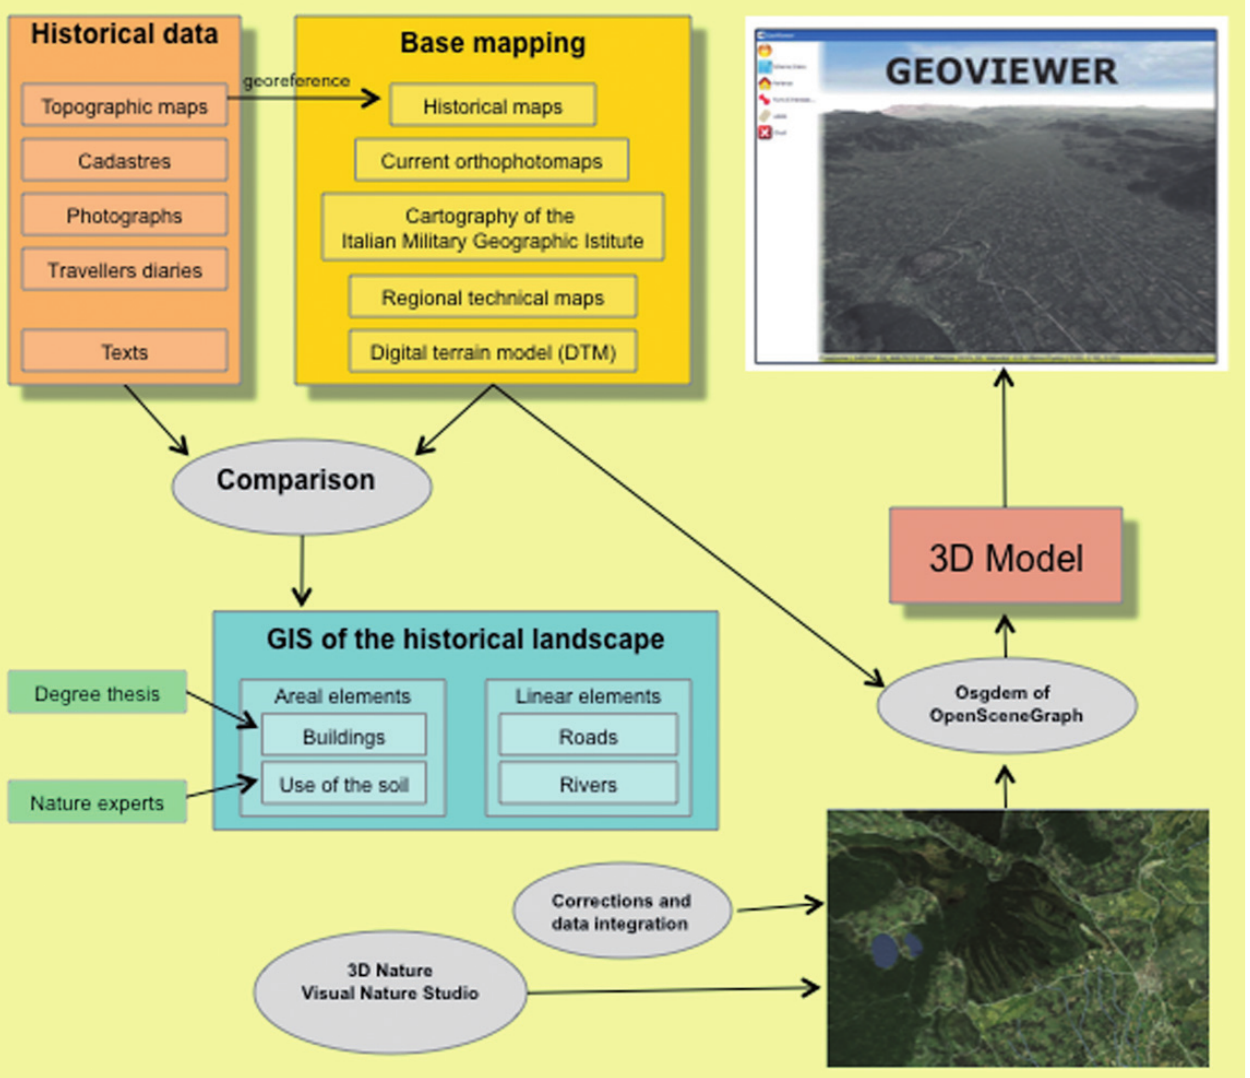
Figure 4. Scheme of the work phases that led to the realisation of the virtual historical landscapes for the three-dimensional navigational software